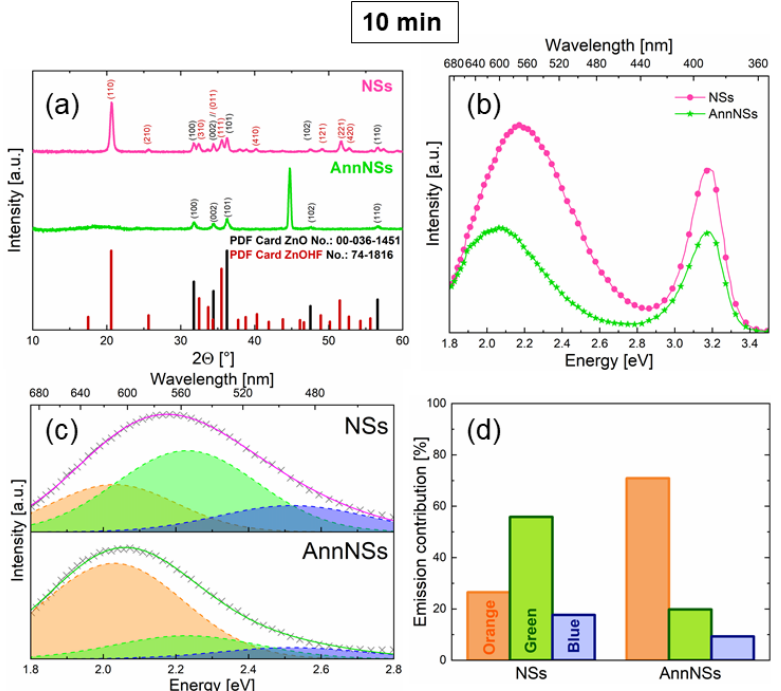
Figure 2. ( a ) XRD pattern of NSs and AnnNSs grown for 10 min; ( b ) room-temperature photolumi- nescence spectra; ( c ) visible emission band fitting with blue, green, and orange contributions, and ( d ) histogram of fit contributions for both NSs and AnnNSs.